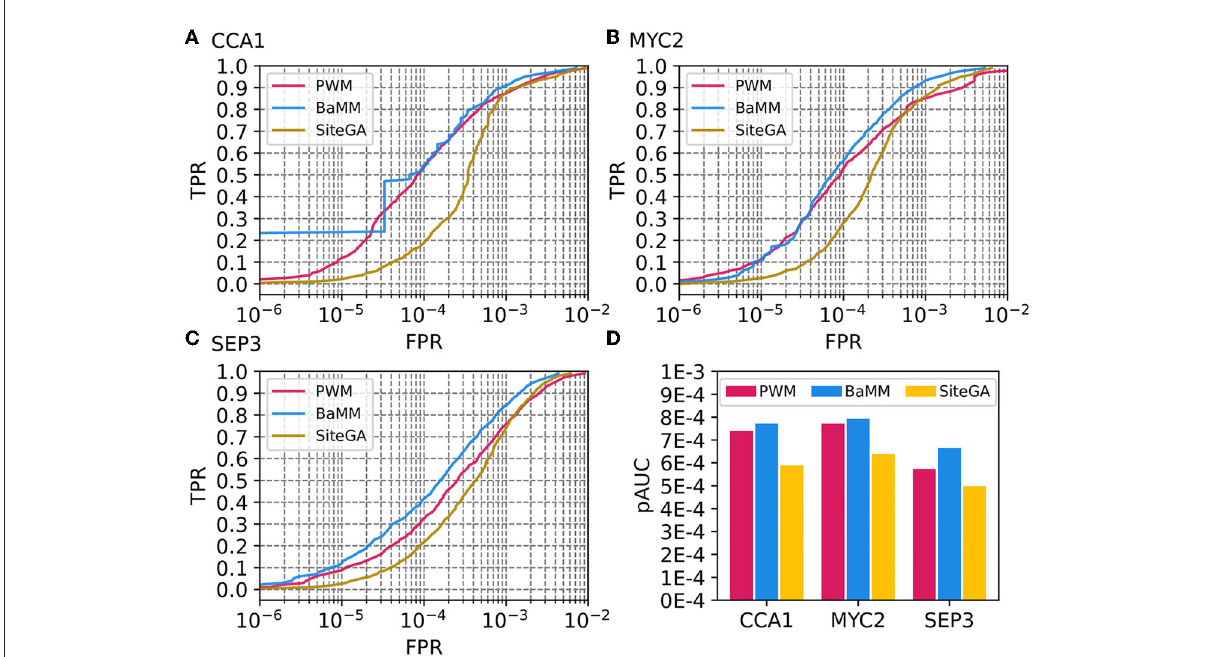
FIGURE2 Performances of PWM, BaMM, and SiteGA motif recognition models for three example ChIP-seq datasets. (A–C) Display ROC curves for datasets of CCA1, MYC2, and SEP3 TFs. We applied the bootstrap cross-validation procedure (see Section 2) and computed for each TPR, (axis Y) FPR values (axes X). (D) Compares performance estimates pAUC for three models and three